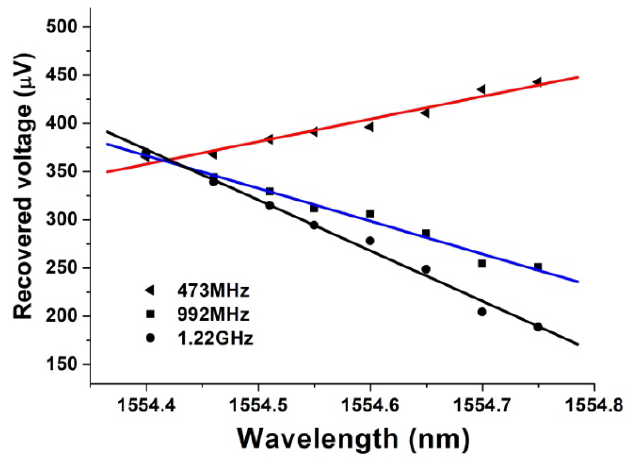
Figure 16. Relationship between recovered RF intensity and the wavelength of sensing FBG at different modulation frequencies (473 MHz: triangles; 995 MHz: squares; 1.22 GHz: